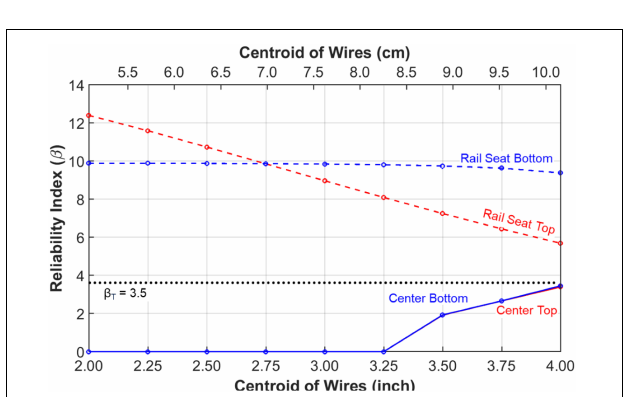
FIGURE 8 | HAL freight center bending moment structural reliability indices ( β ) as a function of top width, while holding other parameters constant.